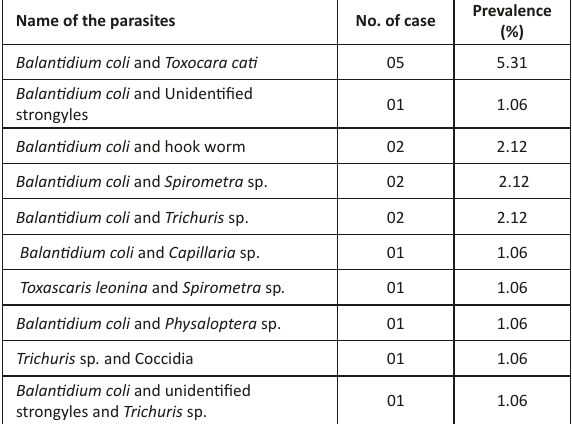
Table 3. Prevalence of mixed infection